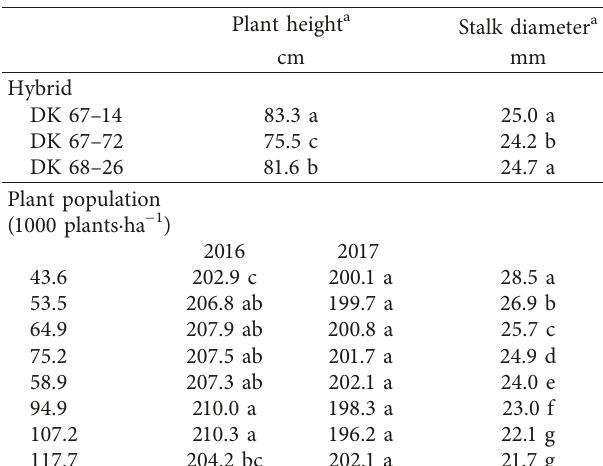
Table 2: Plant height and stalk diameter of corn hybrids and plant populations in 2016 and